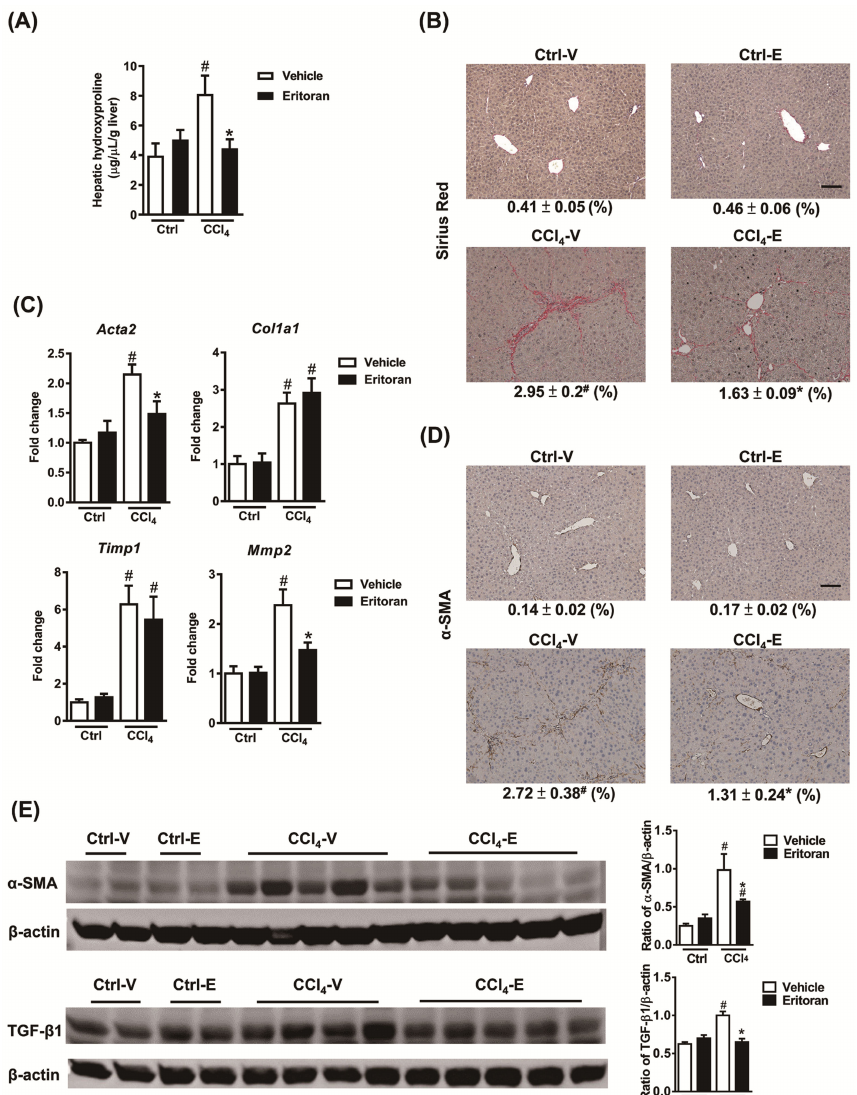
Figure 7. Eritoran attenuated liver fibrosis in the mice injured by CCl 4 . ( A ) Hepatic hydroxyproline levels. ( B ) Sirius Red staining of the liver sections and quantification of the positively stained areas